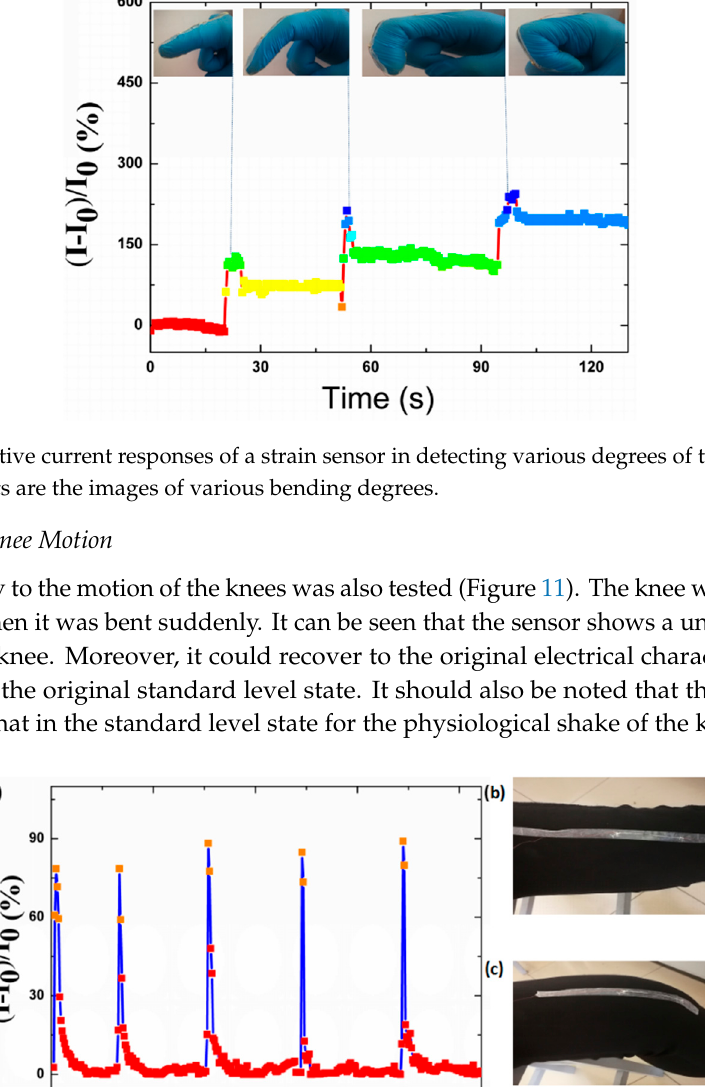
10 of 14 Figure 9. Response of the strain sensor with spring-like configuration worked as wearable sensors in monitoring the stability of forefinger bending. A: The relaxing state of the strain sensor at the point the forefinger was bent suddenly. B: The maximum relative current variation of the strain sensor to the response of bending the forefinger. C: The bending state of the strain sensor at the point the